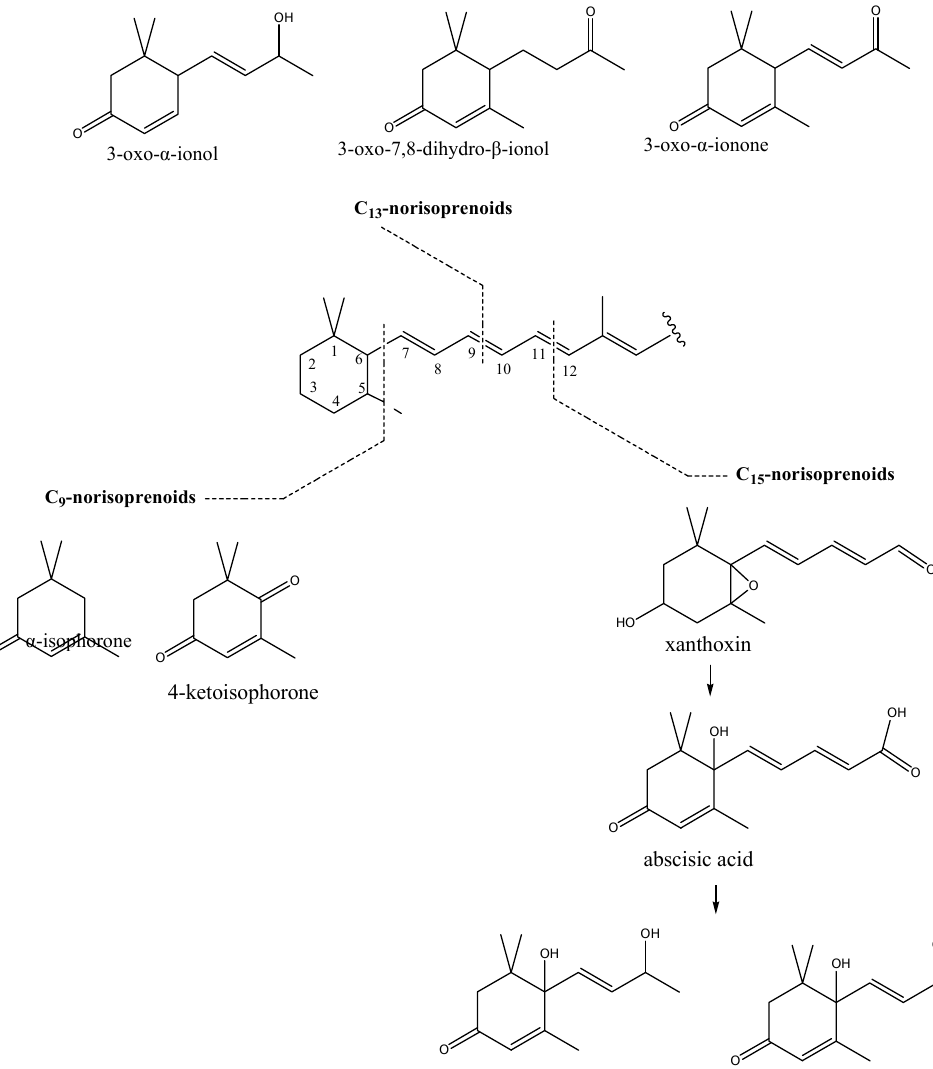
Figure 2. Different classes of degraded carotenoids and identified compounds in sulla honey from the classes of C